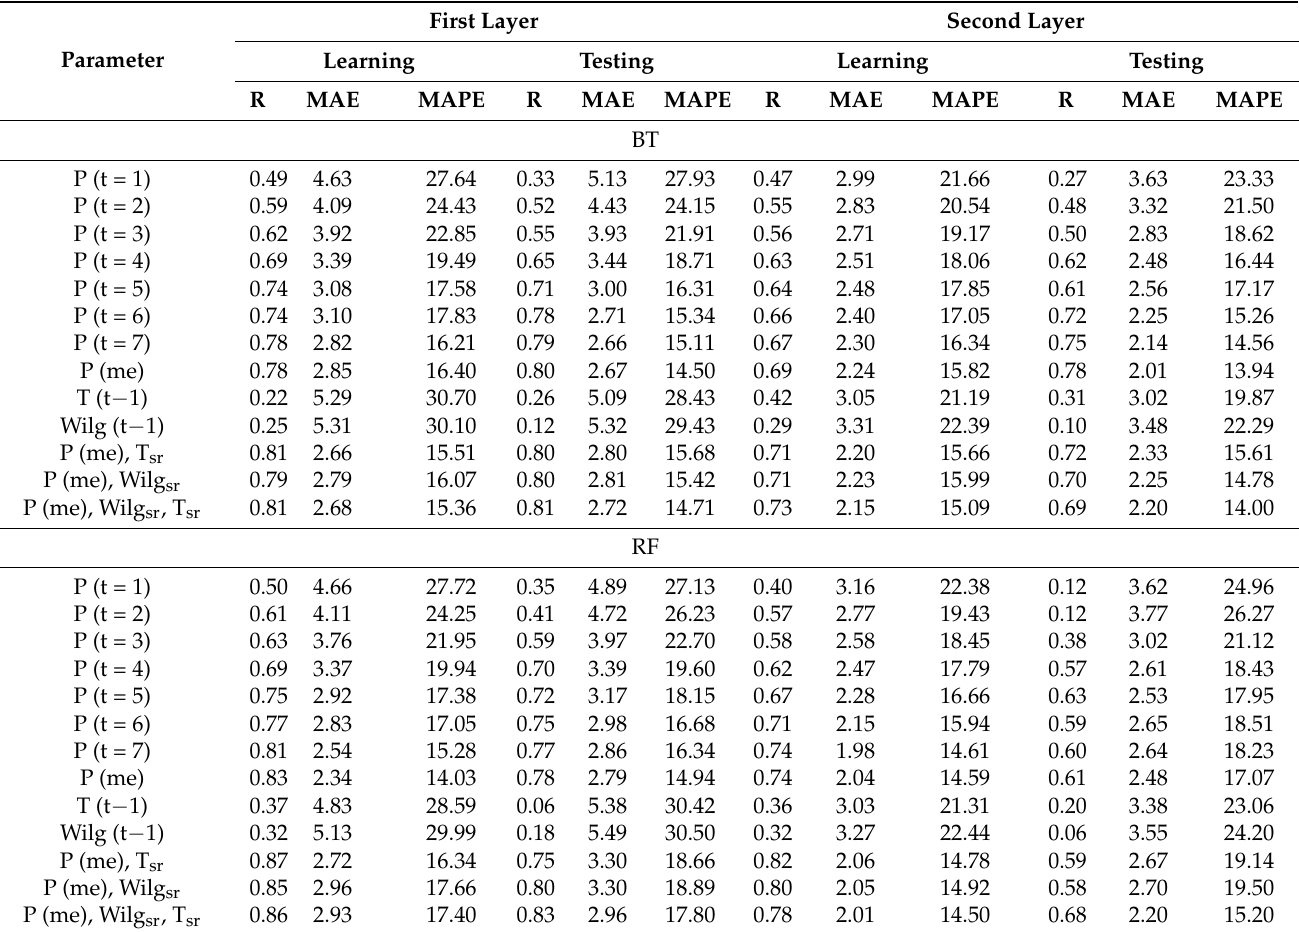
Table 4. Comparison of predictive capabilities for BT, RF